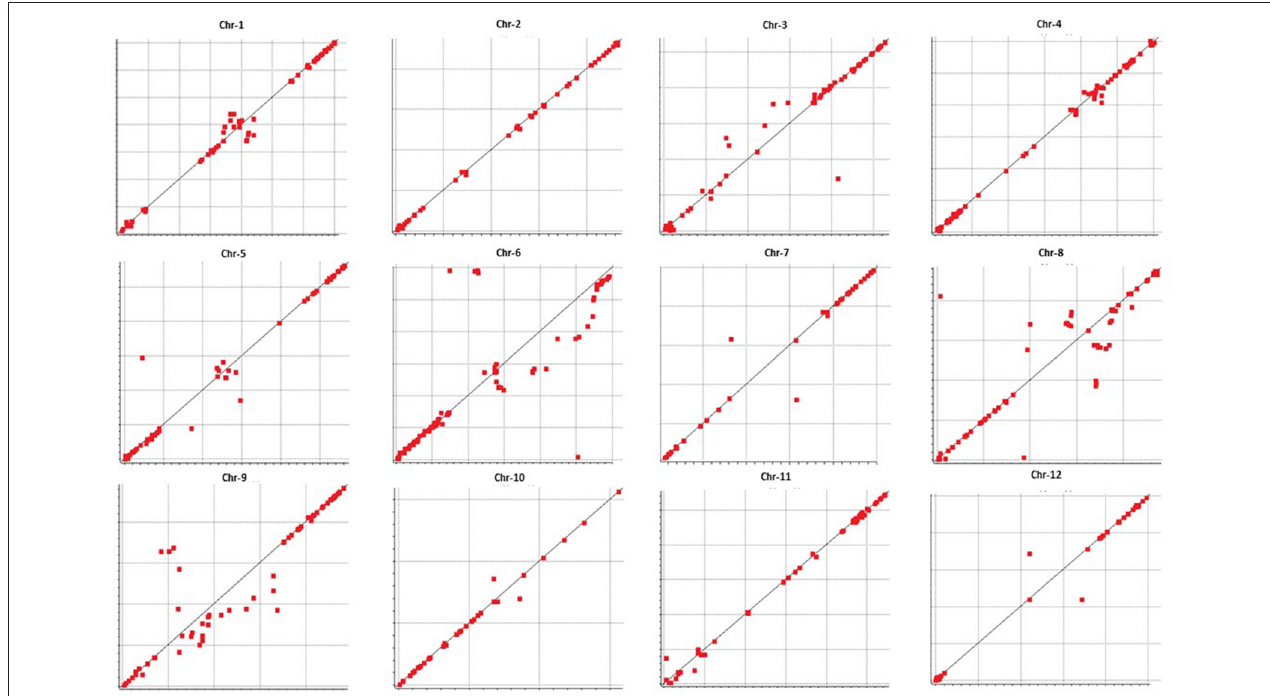
FIGURE 6 | Collinearity between genetic (vertical axis) and physical maps (horizontal axis) (markers that are distant from the “line of best fit” are not collinear).